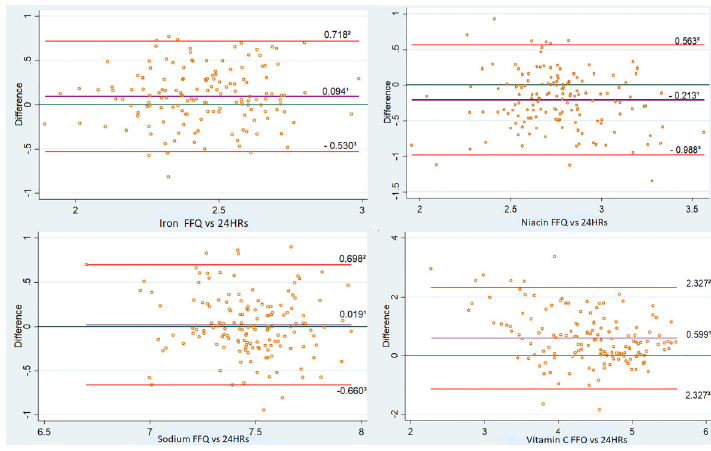
Figure 2. Mean difference of the three 24-hour recalls (24HRs) and the food frequency questionnaire (FFQ) and superior and inferior limits of agreement with log-transformed data for iron, niacin, sodium, and vitamin C. São Luís, Maranhão, RPS Cohort Consortium 2016